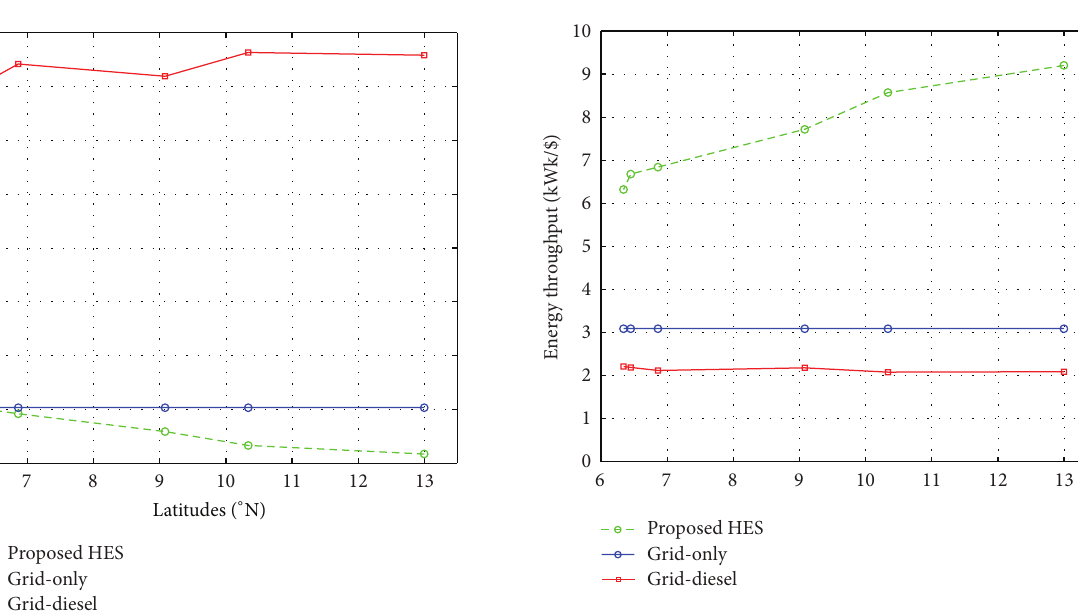
Figure 9: Variation of the economic cost of the proposed and existing energy systems with geographical locations.